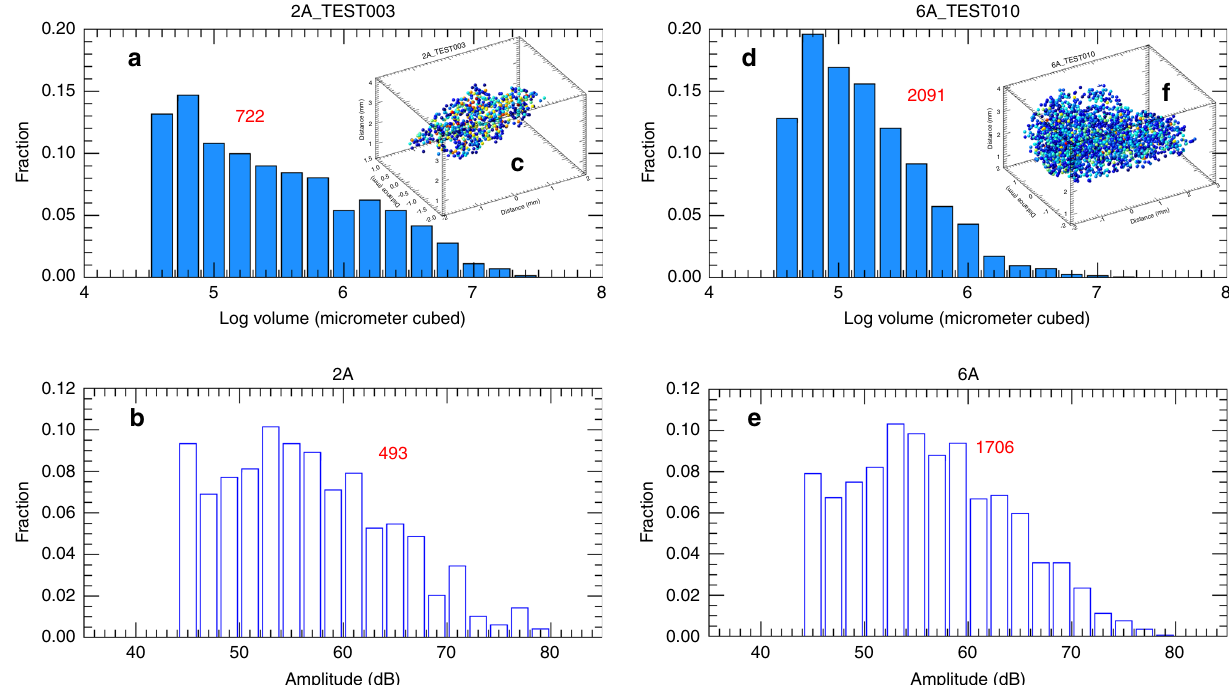
Fig. 2 Bubble and acoustic amplitude distributions. a , d Probability distribution of bubble volume (in log 10 ) for single-grain samples CD2A and CD6A (see Supplementary Table 1). b , e Distribution of the logarithm of energy generated by the bubbles in the grain (number of recorded events shown in red and based on recorded events from one of the sensors). c , f 3D visualization of the center of mass of the bubbles within each single grain (number in red is number of bubbles) from X-ray imaging. occur until 10 min after the fl uid started imbibing (light green others are not. During setup of the fracture, the dust is crushed contour in Fig. 4c). A fi nger of small apertures in the mid-fracture when the two surfaces are registered, resulting in multiple plane ( x ~ 0.1 between 0.1 m < y < 0.15 m) resulted in a delay of particles (e.g., multiple stars near sensors 1, 5, and 6 in Fig. 4b) the fl uid front movement, as indicated by the dip in the time- that can potentially move with the invading front. The acoustic lapse acoustic map near a horizontal position of 0.13 mm. This locations agree with the visual location of the fl uid front to within demonstrates that the chattering dust does not emit until water ±5 mm. This agreement illustrates the potential to use chattering reaches a dust grain and dissolution begins. Some of the locations dust to track fl uid front movement through fractures in opaque of the emissions are near the original placement of the dust, while material (i.e., rock) at the laboratory scale and potentially at the NATURE COMMUNICATIONS| (2020) 11:5282